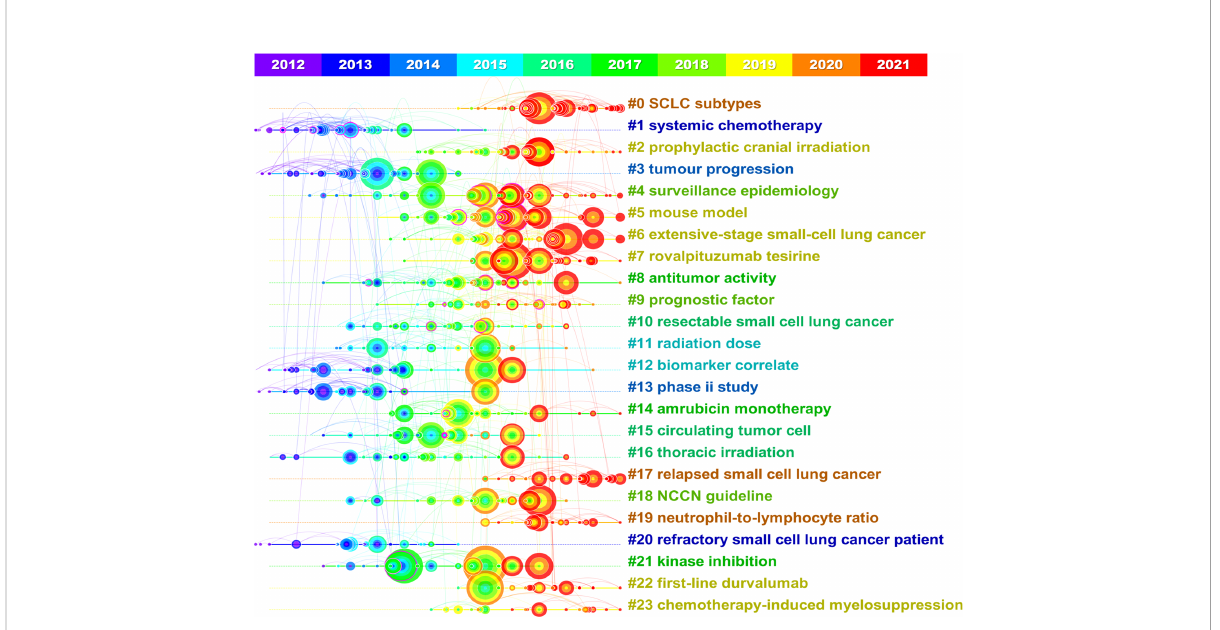
FIGURE 9 Timeline view of co-citation reference. The timeline from left to right represents the time evolution from 2012-2021. Nodes composed of different colors represent citations. The greater the node is, the larger the citations ’ quantity is. The color of the node corresponds to the cited time for the time band. The timeline view visually shows the rise and fall of each